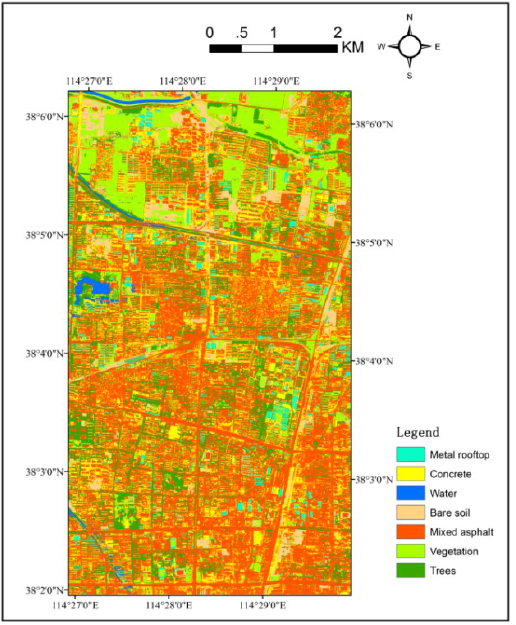
Figure 9. LCTs map derived from WV2 image and SASI image using SVM and watershed segmentation